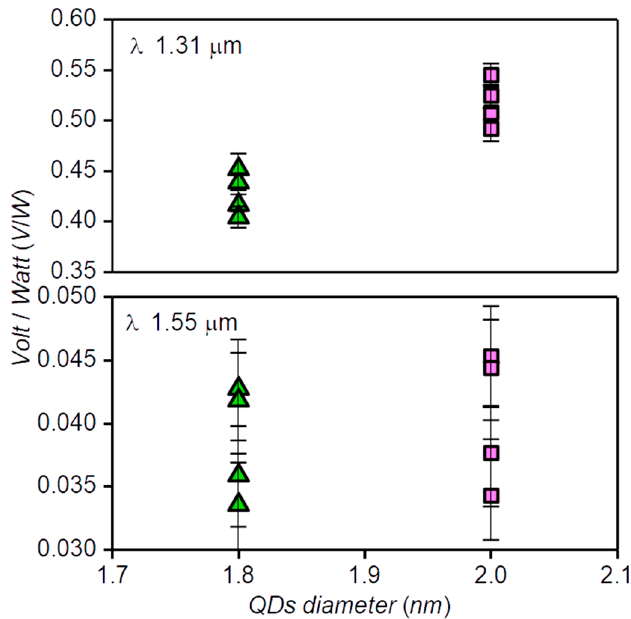
Figure 7. The responsivity measured for two groups of devices with QDs of diameters 1.8 and 2 nm at radiation wavelengths of 1.31 and 1.55 μ m, which are shown in the upper and lower panels, respectively. The responsivity at λ 1.31 μ m for heterostructures with a QD size of 2 nm is noticeably larger than that for heterostructures with a QD size of 1.8 nm. For the same devices, measurements at λ of 1.55 μ m do not reveal any dependence on the size of the QD within the experimental error.